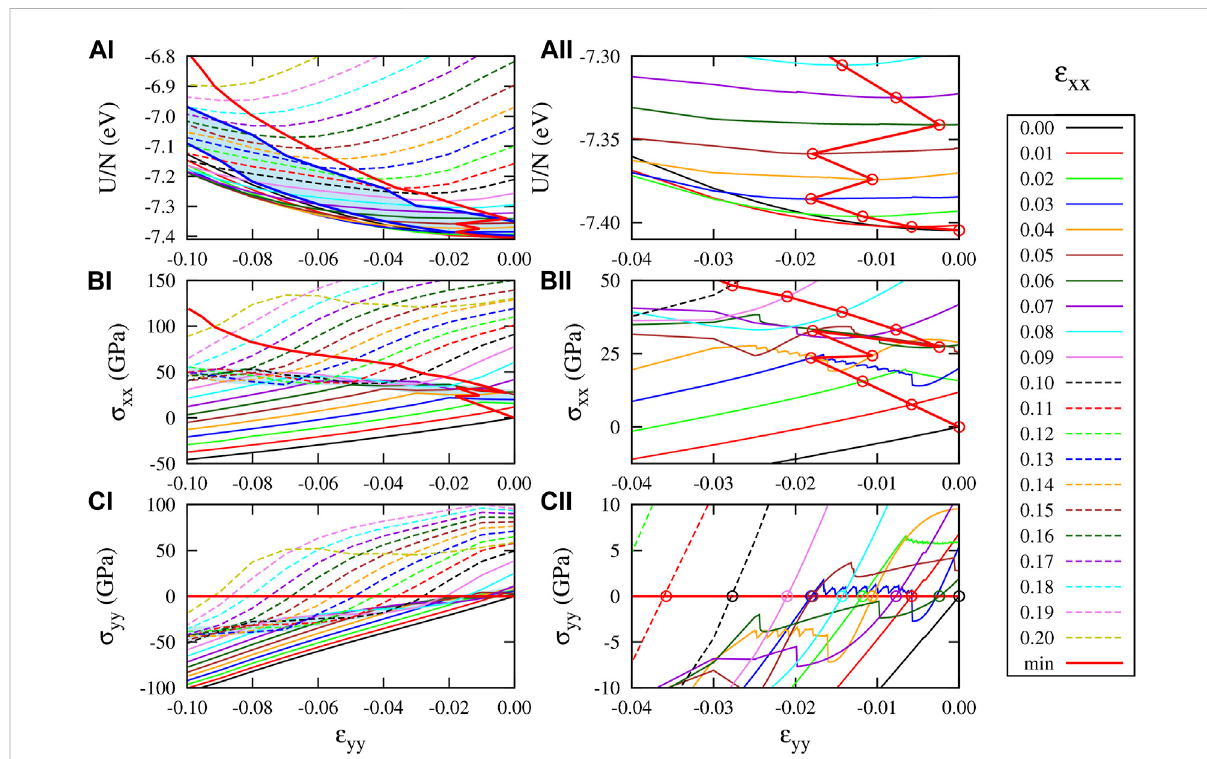
FIGURE 5 Response of graphene to strain ε xx and ε yy according to the CHON-2019 potential. (AI) And (AII) U ( ε xx , ε yy )/ N (BI) and (BII) σ xx ( ε xx , ε yy ), and (CI) and (CII) σ yy ( ε xx , ε yy ). The right panels ((AII) (BII) and (CII)), present the same results with those presented in the left panels ((AI) (BI) and (CI)) but in different scale range ( − 0.04 ≤ ε yy ≤ 0) to provide details for the “ jumps ” of the optimum strained graphene structure at low strain ε xx values. The curves presented in those plots correspond to constant strain ε xx , for the ε xx values shown in the legends. The ε yy increment in these plots is 10 – 4